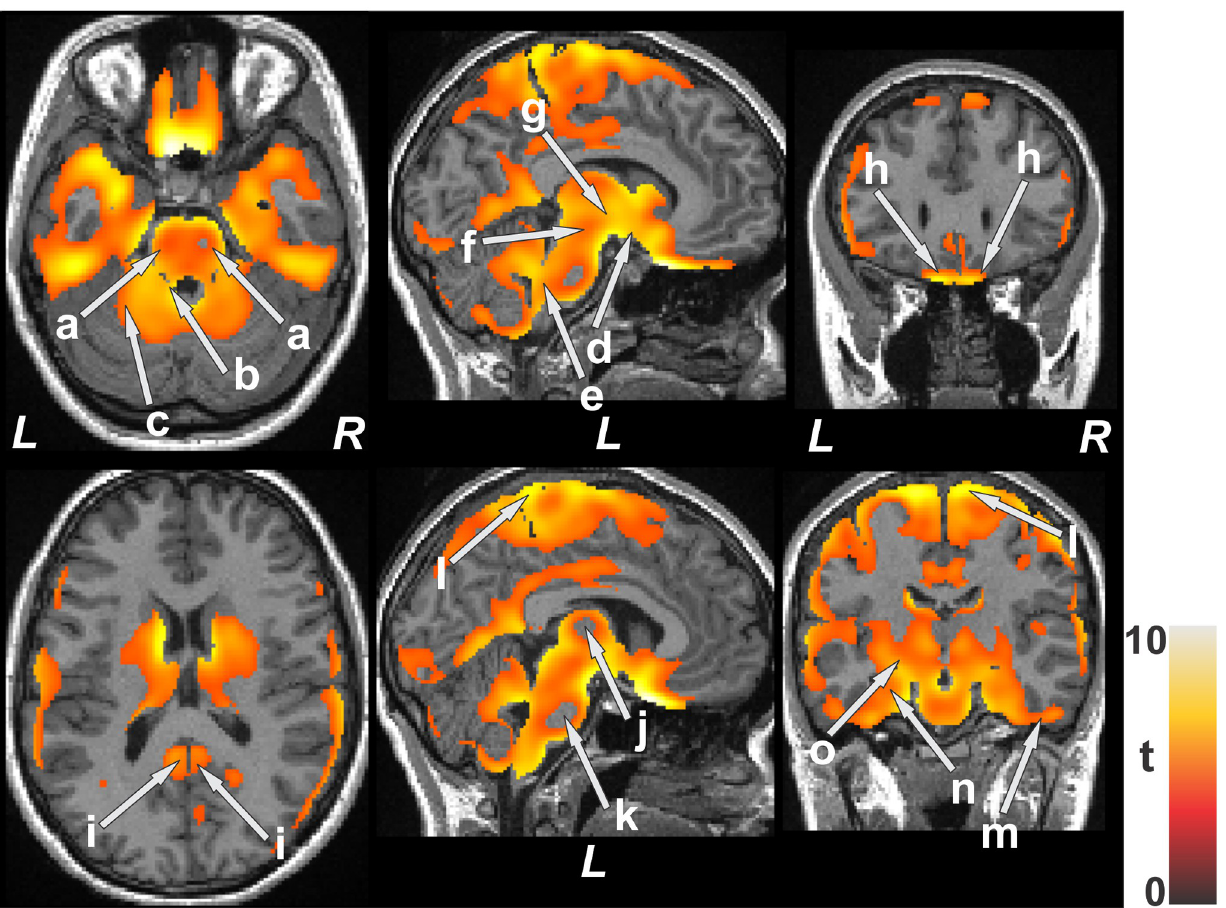
Fig 1. Brain areas demonstrating decreased entropy (colored) in dorsal and ventral pons (a), deep cerebellar nuclei (b), anterior cerebellum (c), ventral medial frontal cortex (h), extending through the hypothalamus and basal forebrain (d) to the thalamus (g), midbrain (f), dorsal and ventral medulla (e) in TC patients vs controls (p < 0.01), corrected for multiple comparisons. Near-midline slice illustrating extensive entropy declines bilaterally in the ventral temporal cortex (m), and includes the hippocampus (n) and the basal ganglia (o); sparing of deeper tissue in the thalamus (j) and pons (k) is apparent. Extensive entropy declines bilaterally in the sensorimotor cortex (l), as well as posterior cingulate (i) in TC patients